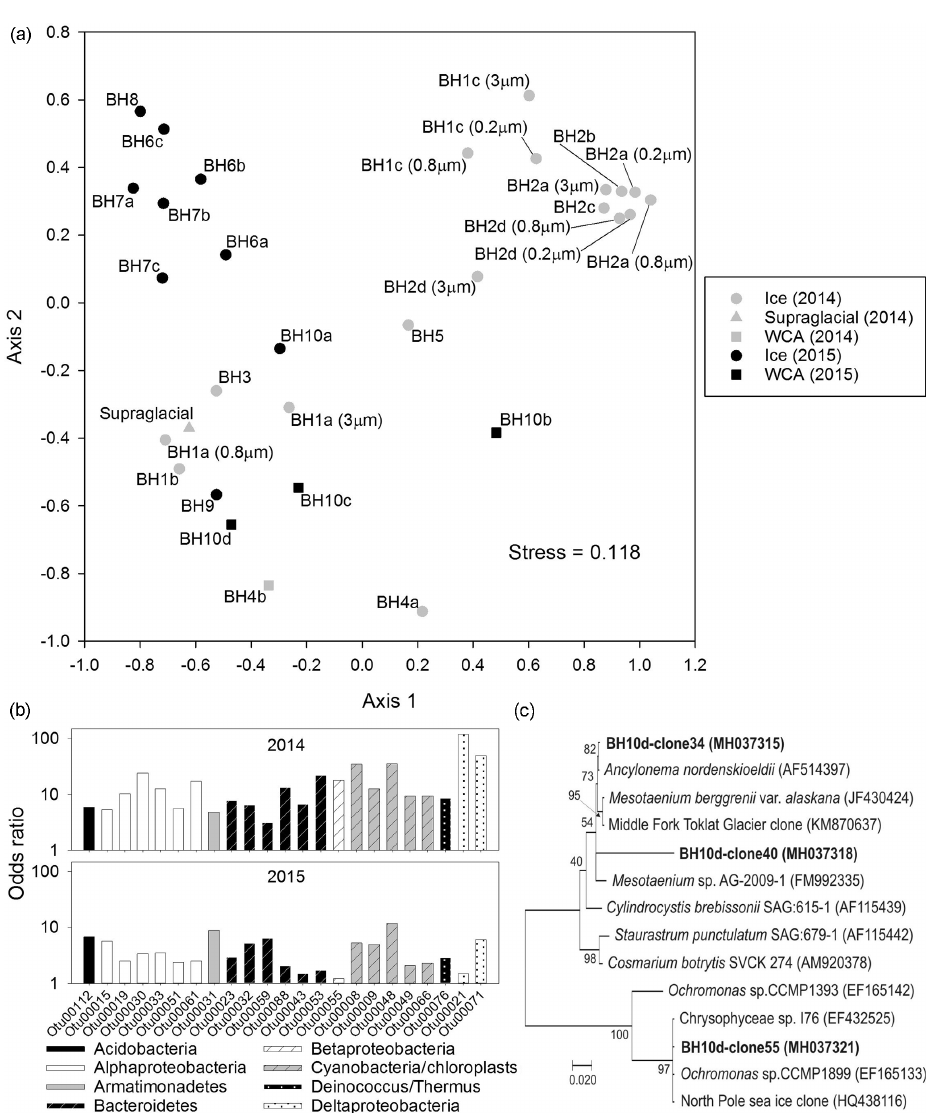
Figure 6. Microbial community structure in the ice and WCA based on analysis of 16S/18S rRNA genes. (a) NMDS ordination plot of communities observed in samples of englacial (upper left and right) and near-surface (bottom) ice. (b) Odds ratios for taxa enriched in the near-surface ice samples. The OTUs shown have abundances > 0 . 25% of all sequences and odds ratios > 5-fold in samples from 2014 or 2015. (c) Phylogenetic analysis of amplified 18S rRNA gene sequences (positions 566 to 1200, Saccharomyces cerevisiae numbering) related to algae in the Zygnematophyceae and Chrysophyceae classes. GenBank accession numbers are listed in parentheses. The scale bar represents 0.020 substitutions per site and bootstrap values are shown as a percentage of 1000